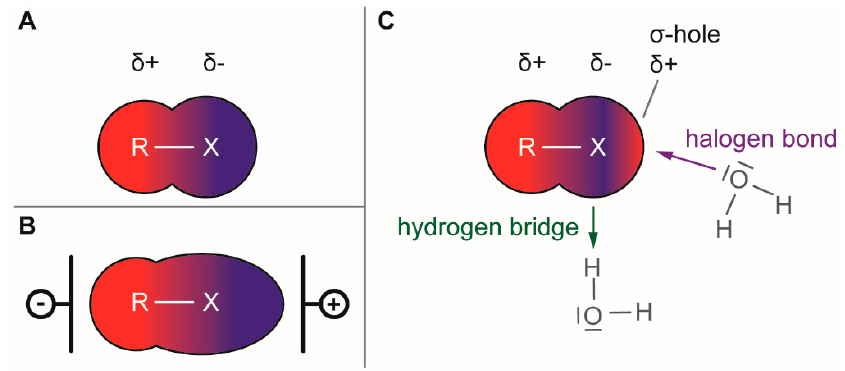
Figure 1. Schematic representation of electron distribution in halogens. ( A ): Latent polarization of a carbon-halogen bond. ( B ): Polarizability of large halogens (Br, I) bonded with a carbon. The external electrical field, for example, caused by an approaching electrophile / nucleophile leads to the distortion of the electron density. ( C ): Schematic view on the “ σ -hole”. The electron density is drawn to